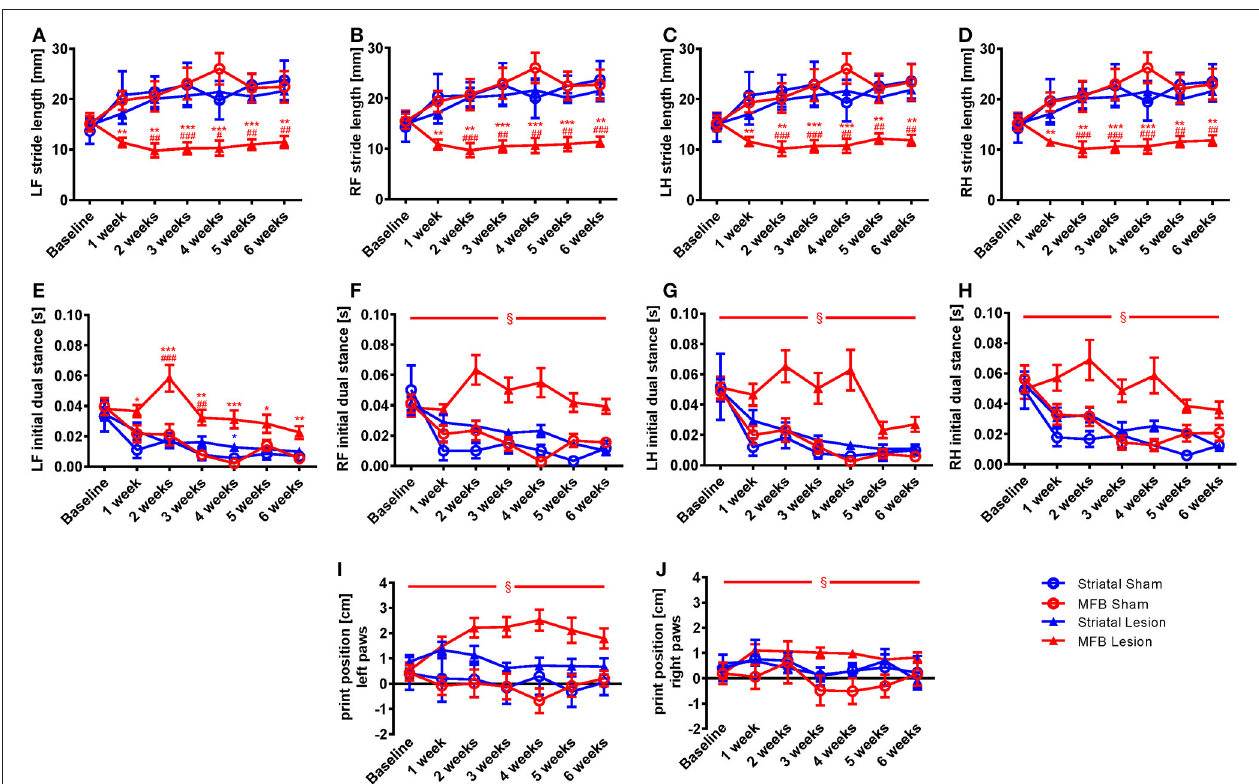
FIGURE 3 | Stride length, initial dual stance and print position following MFB and striatal 6-OHDA lesioning. Graphs demonstration (A–D) the average stride lengths for each paw, (E–H) duration of simultaneous contact of hind or front paws with the walkway (dual stance), (I–J) the distance between the position of the hind paw and the position of the previously placed front paw on the same side of the body. LF, left front, RF, right front, LH, left hind, RH, right hind. Data shown as mean ± s.e.m. *Indicates a significant difference on the lesion group when compared to its control (blue for striatal cohort and red for MBF cohort) and # indicates differences of MFB lesion vs. striatal lesion animals. * P ≤ 0.05; ** P < 0.01; *** P < 0.001 (Two-way repeated measures ANOVA with Tukey’s or Dunnett’s post-hoc multiple comparison when interaction time × treatment was significant). § Indicates a significant influence of the treatment factor independently, when comparing the four different